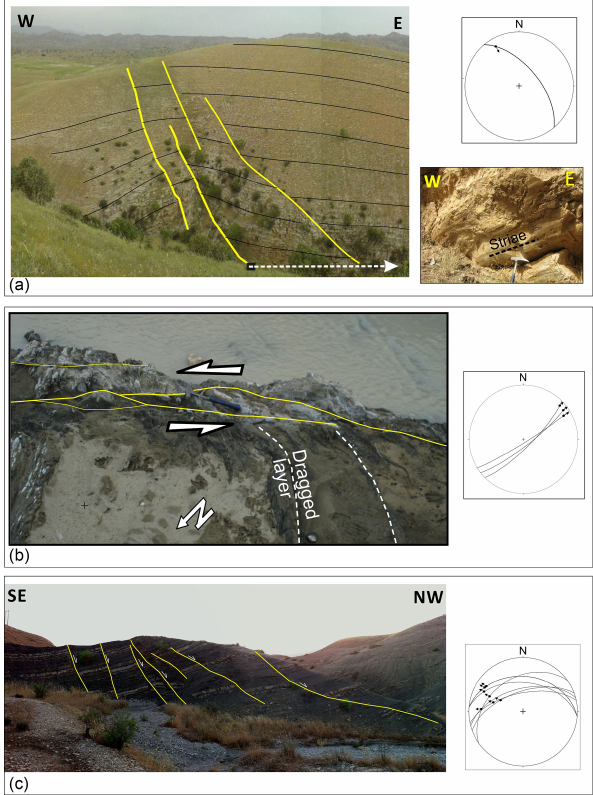
Figure 16. Photographs of fault zones in the Salas area: (a) dextral- slip fault (b) sinistral-slip fault and nearby dragged layers; (c) nor- mal faults with sinistral components. For the locations, refer to Fig.